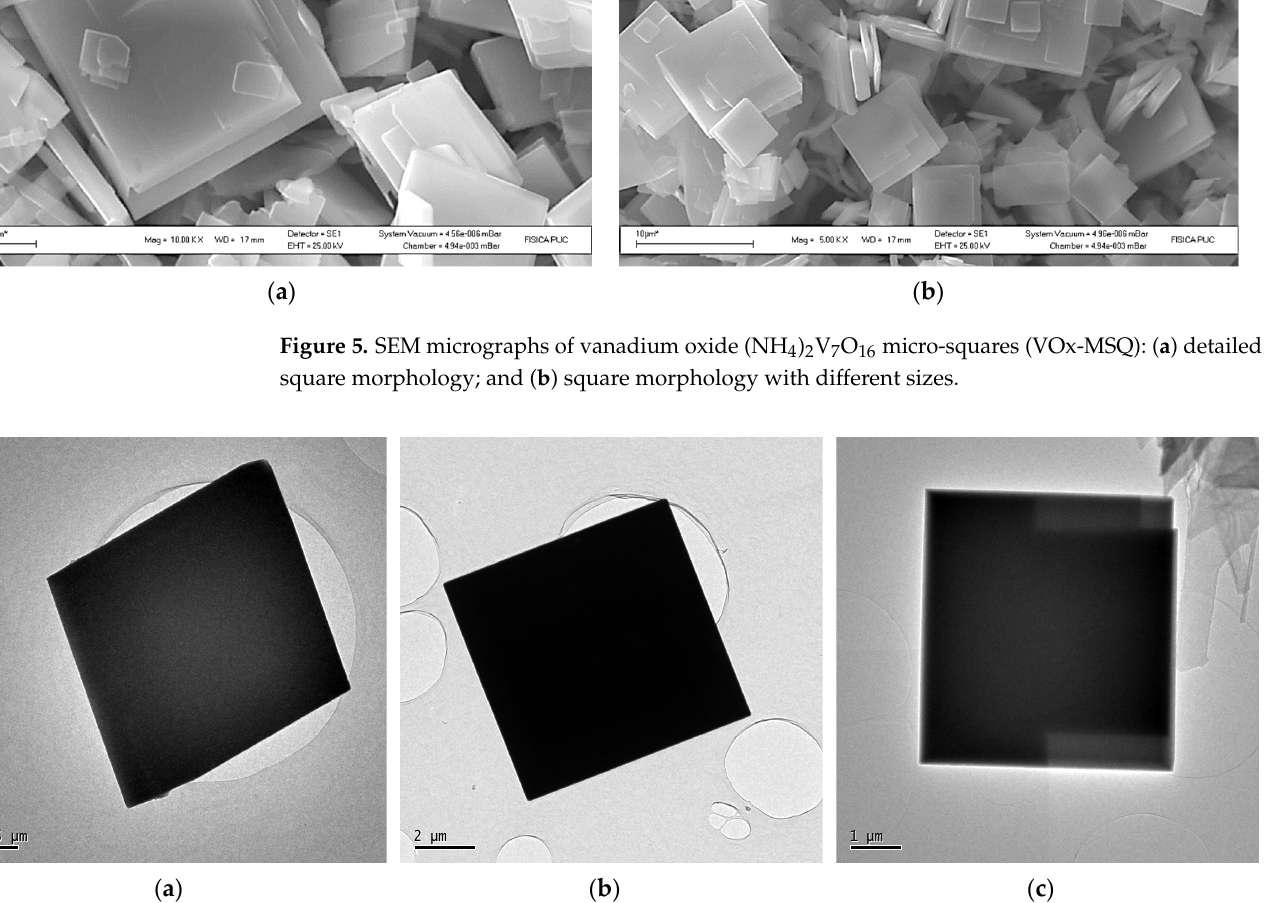
Figure 6. TEM micrographs of vanadium oxide (NH 4 ) 2 V 7 O 16 micro-squares (VOx-MSQ): ( a ) tilted microstructure square morphology; ( b ) isolated microstructure square morphology; ( c ) overlapped VOx-MSQ.